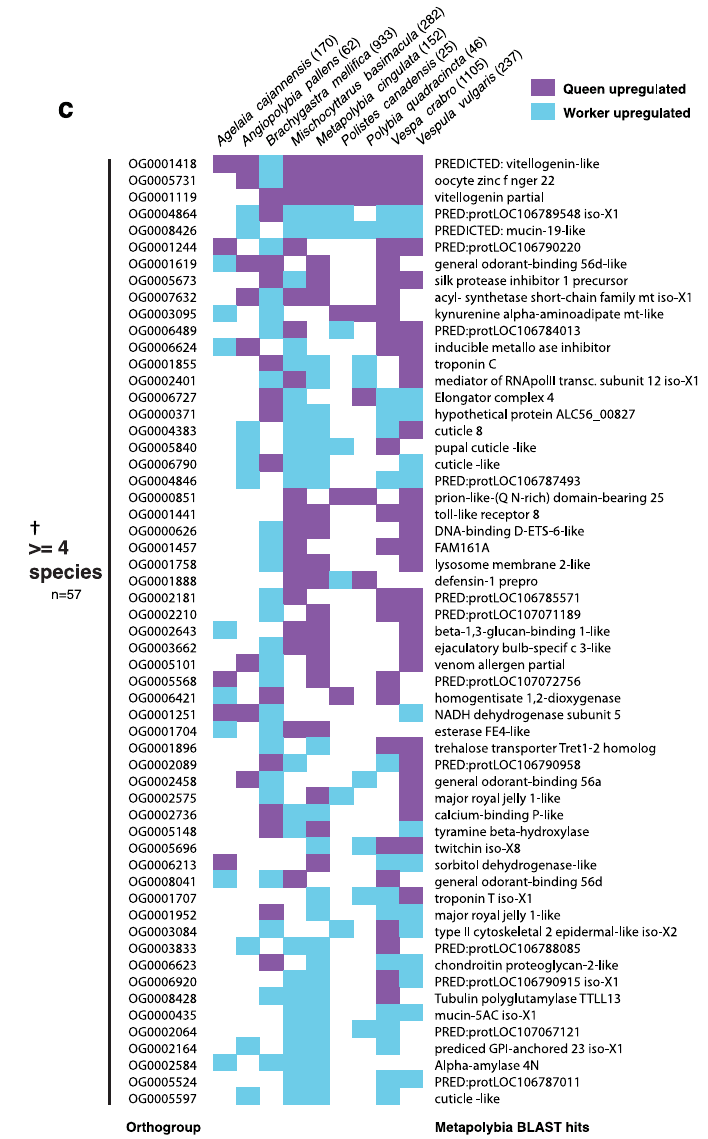
Fig. 3 | Overlap of differential caste-biased genes (queen vs worker) and their functions. a Frequency of caste DEGs in multiple species (observed, bar-plot). Showing numbers of orthologous genes that are differentially expressed in 1 up to 9 species. Atthe top we show the average “ expected ” numbers of DEGs to overlap, basedon1000permutationswithrandomgenes, ” observed ” andFishertwo-sidedP valuesforeachexpected/observedfrequencyindicatethattheobservedoverlapin DEGs are more than expected by chance. Symbols represent datasets used in the gene ontology analysis ( b ) and heatmap ( c , to right). For the full list of genes, see Supplementary Data 3. b A histogram of overrepresented gene ontology terms of genes found differentiallyexpressed inatleast two out ofthe nine species ( n =562